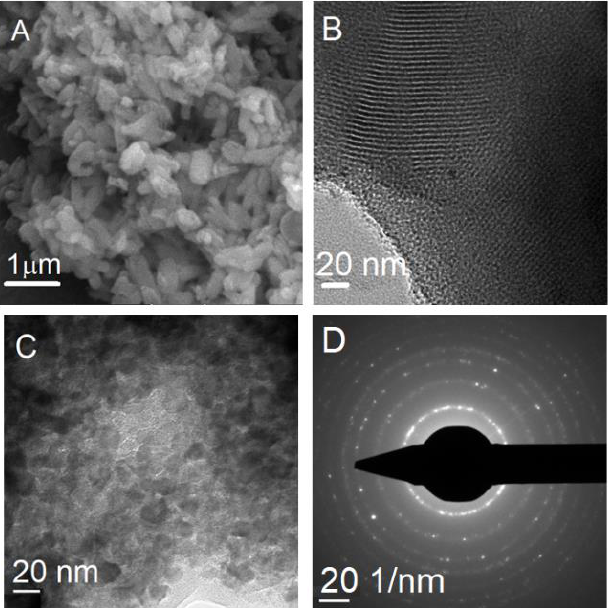
Figure 5. SEM image of ( A ) MCM-41E material; ( B ) TEM micrograph of MCM-41E material; ( C ) TEM image of TiO 2 ; and ( D ) SAED analysis of TiO 2 support.